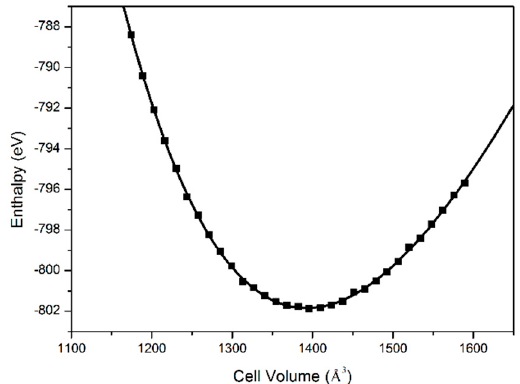
Figure 5. Phonon dispersions and vibrational density of the states (VDoS) of Ca 7 MgSi 4 O 16 -Bre ( V = 1382.18 Å 3 ).